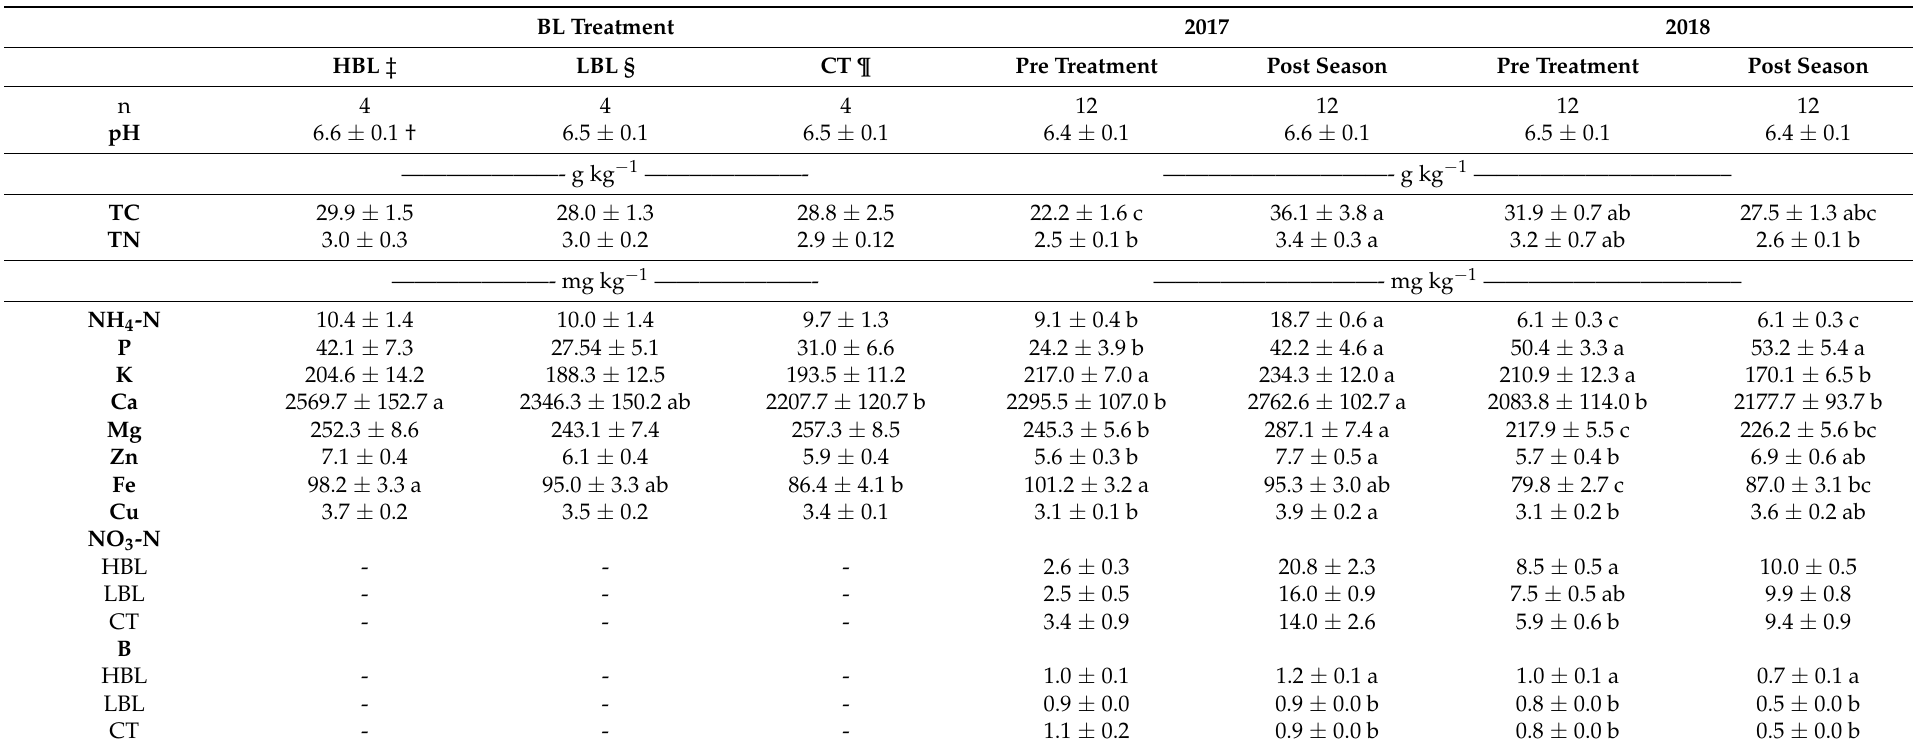
Table 5. Soil properties after BL fertility treatment during pre- and post-growing seasons of 2017 and